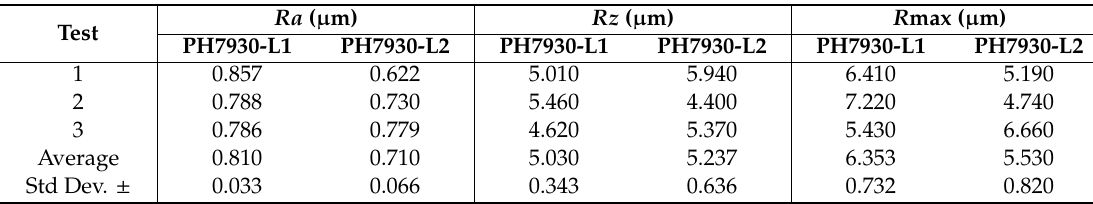
Table 8. Surface roughness for the workpiece surface generated by PH7930 PVD AlTiN coated insert with a cutting length of 7.87 m